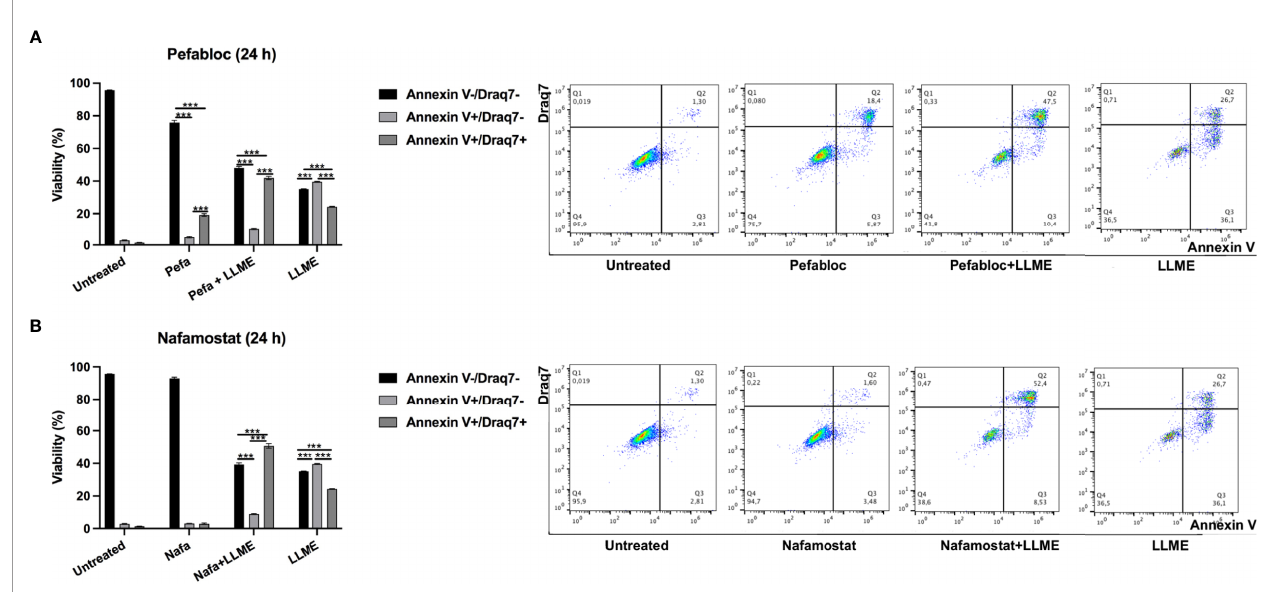
FIGURE 3 | Tryptase inhibition alters the mode of cell death in human mast cell leukemia cells subjected to cytotoxic agent. HMC-1 cells (0.5 x 10 6 cells/ml) were incubated with either Pefabloc SC ( A ; 100 m M) or nafamostat ( B ; 20 m M) for 30 min prior to treating the cells with LLME (400 m M) for 24 h. Cells were analyzed by fl ow cytometry for Annexin V/Draq7 positivity. Dot plots are shown with representative samples showing staining with Annexin V-FITC (FL-1) and Draq7 (FL-3), with the % of cells indicated within each quadrant. Quanti fi cation of the data is shown to the left. Data are representative of at least two independent experiments and are given as mean values ± SEM (n = 3). ***p ≤